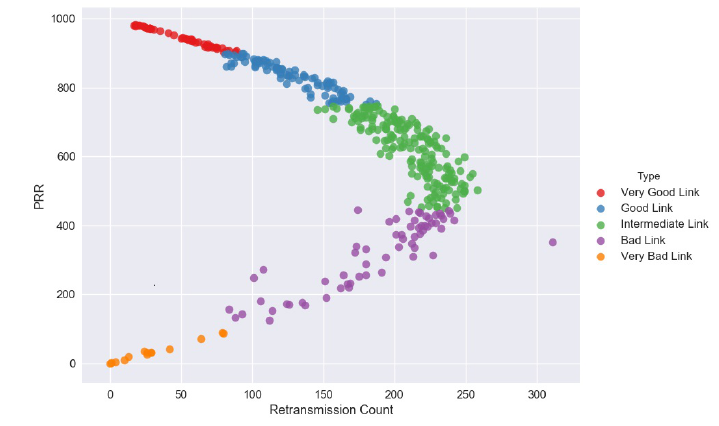
Figure 9. KLSVM: Sensor node observations with PRR greater than 50% have a high degree of negative correlation and a moderate degree of positive correlation for the rest of the observations. These observed links with PRR less than 50% show inconsistent pattern of their retransmission counts, thus the cause of a moderate degree of positive